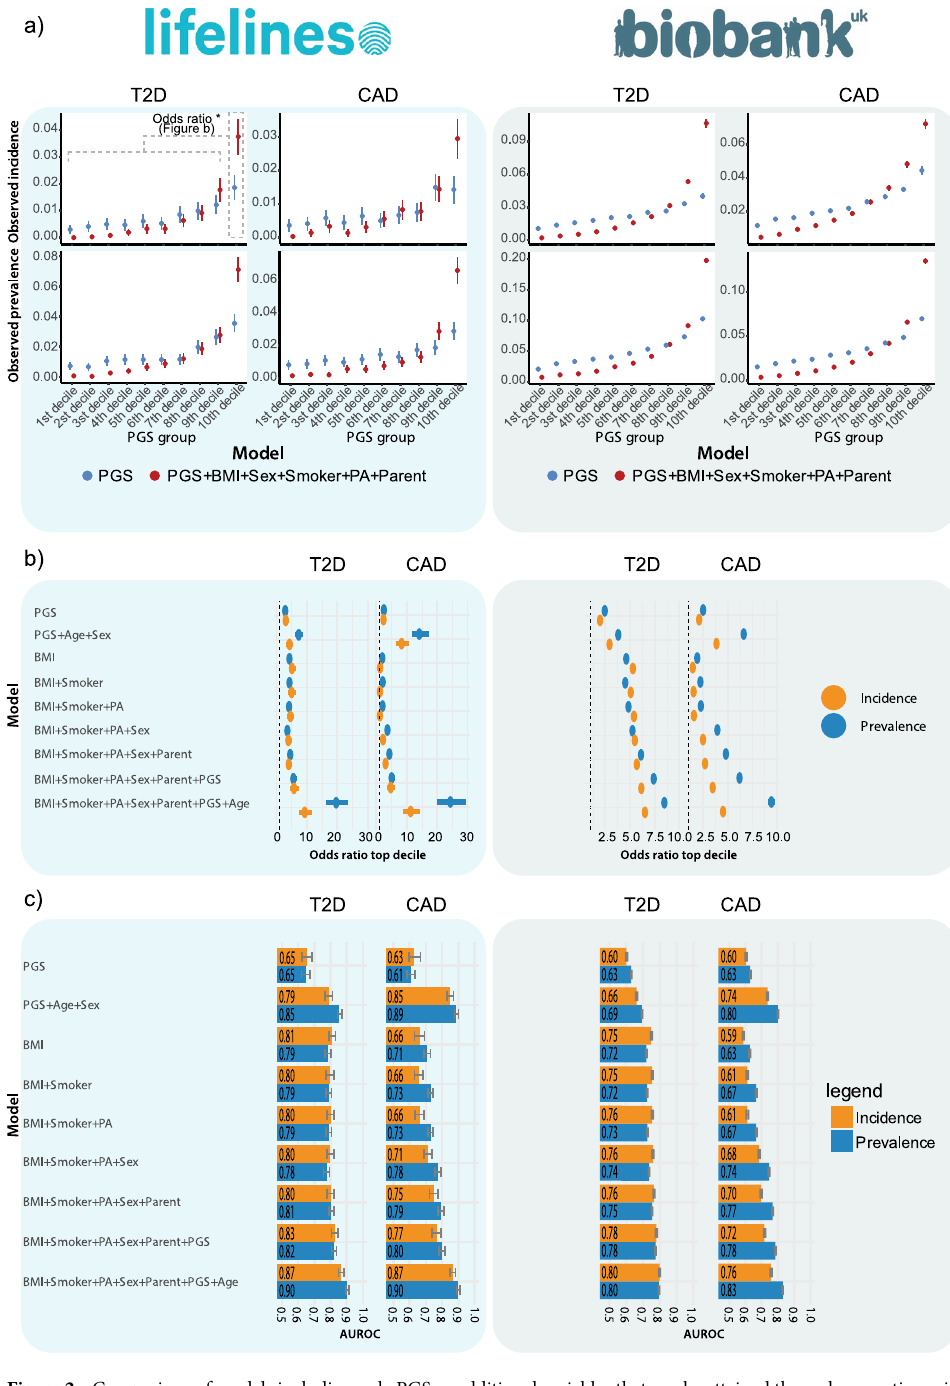
Figure 2. Comparison of models including only PGS or additional variables that can be attained through a questionnaire. Risk predicted with questionnaire-based variables performs similar or better at identifying individuals at high risk (10th decile), compared to PGS. Adding PGS to a questionnaire-based model can, however, further improve the identification of high-risk individuals, but requires a large dataset to be detectable due to its limited effect. For a comparison of risk in different risk strata at different ages, we refer to Supplementary Fig. 2. ( A ) Absolute incidence and prevalence per decile based on PGS alone or combine with additional variables. Performance improves if additional variables are added beyond PGS alone. Risk is increasing exponentially in higher risk categories. ( B ) Odds and incidence ratios of individuals in the top decile according to different models. Model including questionnaire-based risk variables performs significantly better at identifying individuals that will get the respective outcome than a model based on PGS alone. ( C ) C-indexes of the different models. Added value of PGS on top of variables that can be derived from a questionnaire is limited. PGS Polygenic risk score, BMI Body mass index, C-index Harrell’s C-index, PA Physical activity (based on number of days moderate and days of vigorous activity), Parent Parental T2D status, Variables not included as predictors in the model were included as covariates. Additionally, in the UK Biobank, data the first 4 PCs and genotyping batch were included as covariate. Bars indicate 95% confidence interval. For numerical representation we refer to the Supplementary Table